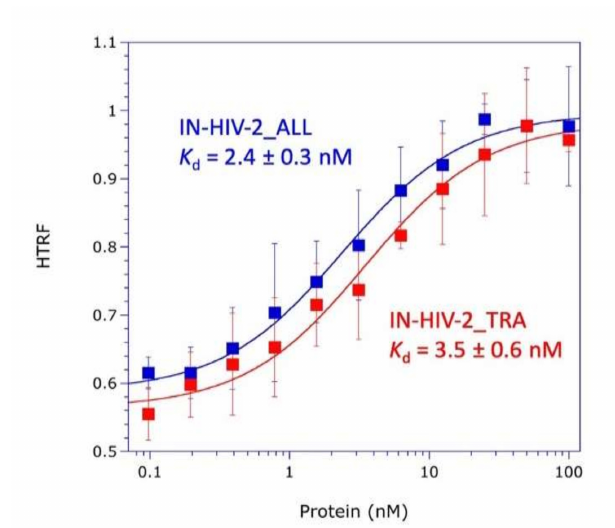
Figure 4. Association of IN from HIV-2 with mLysRS. The binding a ffi nities of mLysRS to IN-HIV-2_TRA and IN-HIV-2_ALL were determined in an HTRF assay using 1.5 nM of HA-tagged mLysRS and increasing concentrations of His-tagged IN-HIV-2 species, expressed as dimer concentrations. Experimental values (symbols) were fit (curves) to a binding equation assuming that one molecule of IN binds one molecule of mLysRS. The binding constants and the associated standard deviations ( n = 3) are